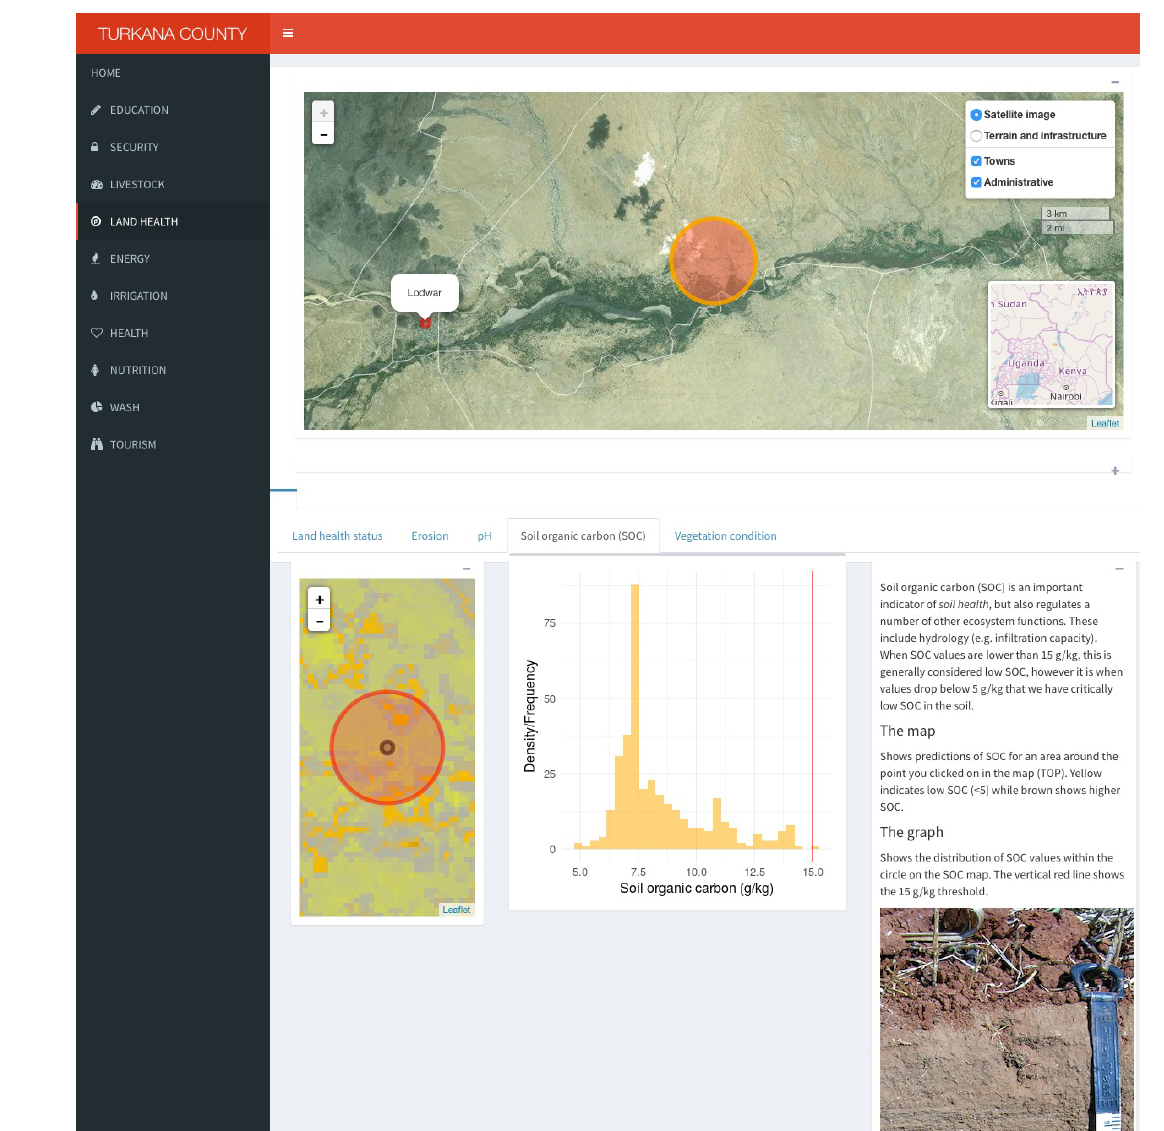
Figure 5. The SOC assessment part of the Turkana Resilience Diagnostic and Decision Support Tool, which is part of the land health section of the